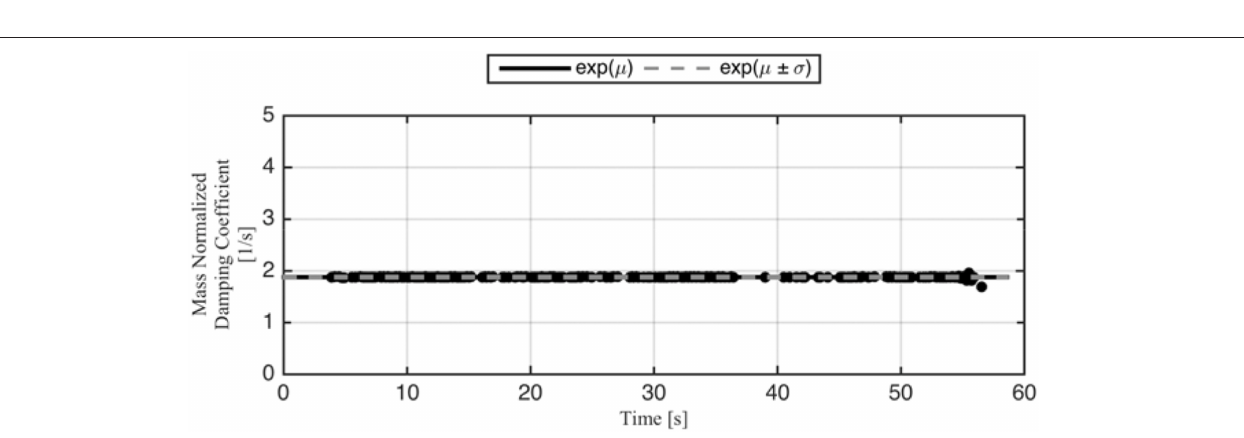
as the exponential value of the logarithmic mean shown in Figure 6 . As mentioned earlier, a constant 5% viscous damping ratio was used in the simulations. The effective viscous damping ratio is estimated using Equation (3). It is at 5% of the critical damping was present in the model, i.e., it estimates the damping ratio with no error. Ground motions with different frequency contents are used in the dynamic response simulations of structures with different levels